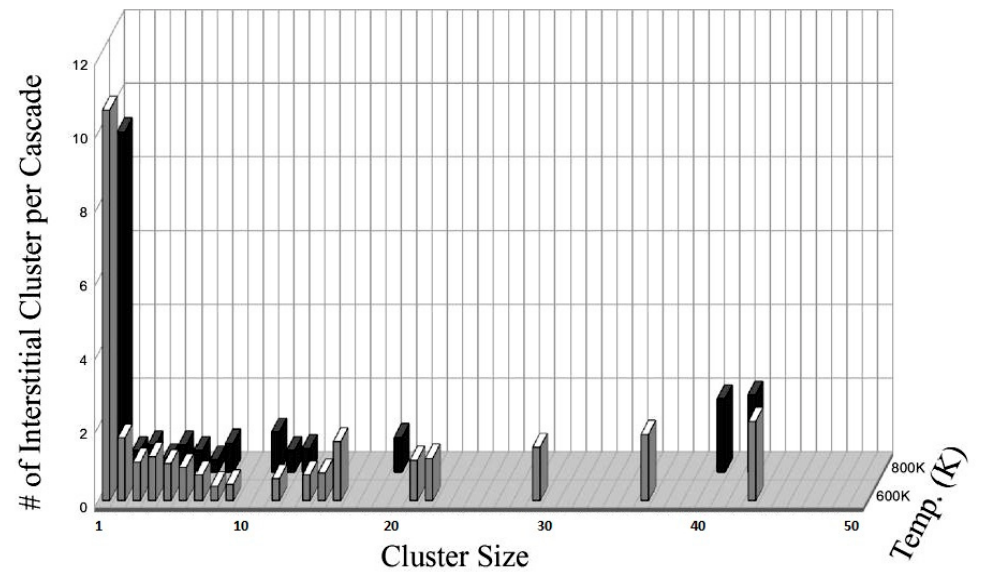
Figure 6. Interstitial cluster distribution at 600 K (white column) and 800 K (gray column).